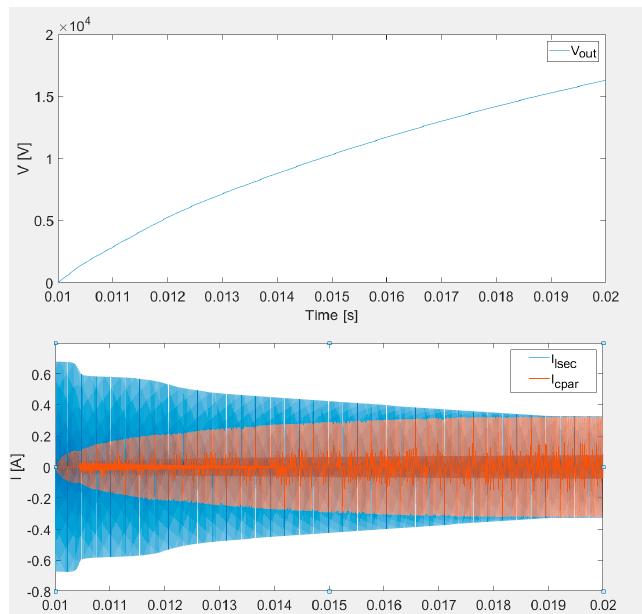
Figure 4. The value of the peak voltage on the transformer secondary winding (Uout), the current induced in the secondary winding (lsec) and the current flowing through the parasitic capacitance of the secondary winding (Icpar) during charging a 10 nF capacitor.